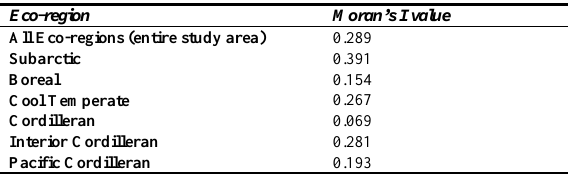
Table 3. Global Moran’s I values for each